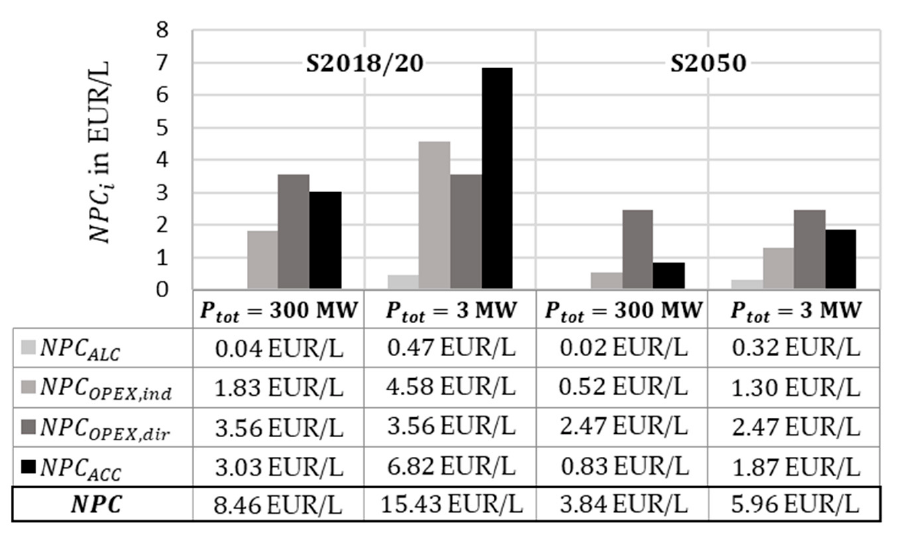
Figure 13. Comparison of net production costs (NPC) of different plant sizes for S2018/20 and S2050. Based on the hourly share of renewable energy and the corresponding average price